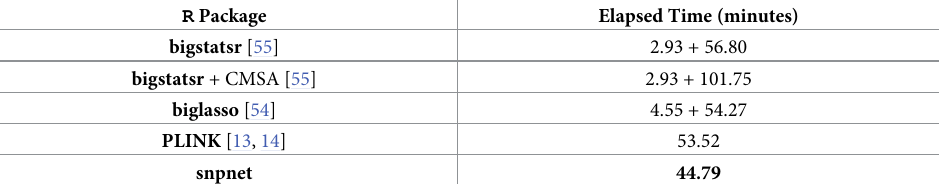
Table 5. Timing comparison on a synthetic dataset of size n = 50, 000 and p = 100, 000. The time for bigstatsr and biglasso has two components: one for the conversion to the desired data type and the other for the actual computation. The experiments are all run with 16 cores and 64 GB